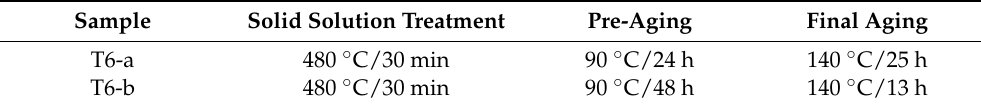
Table 2. Process stages and parameters for Al-5.8Mg-4.5Zn-0.5Cu alloy samples under the T6